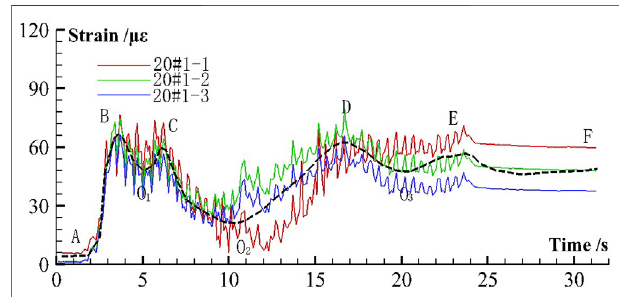
Frontiers in Earth Science |